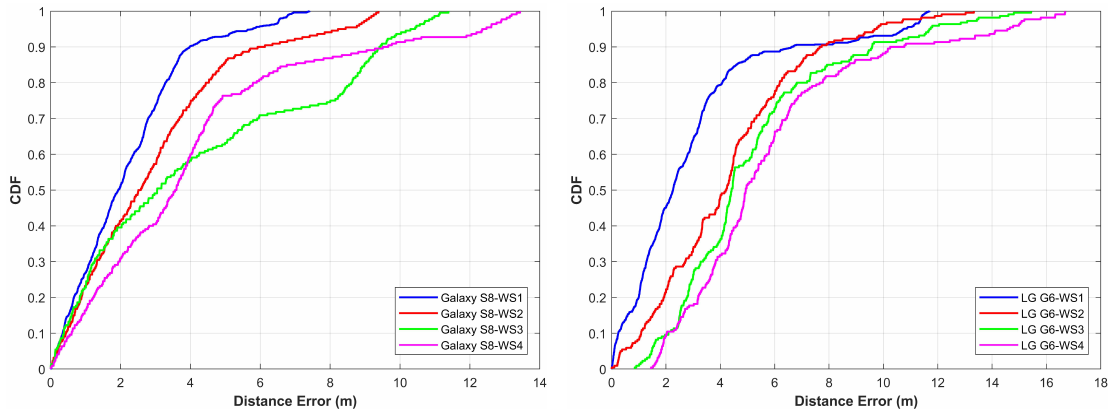
Figure 16. The cumulative distribution function (CDF) of Galaxy S8 and LG G6 for IT